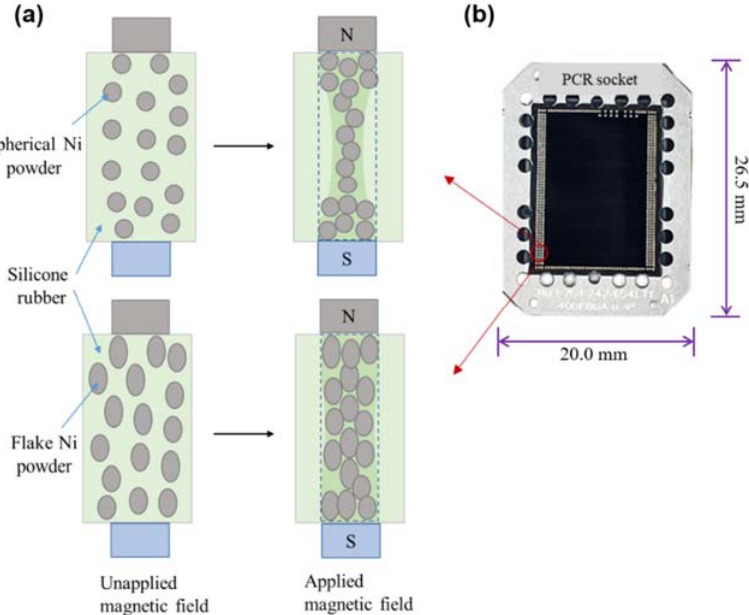
Figure 1. ( a ) Schematic diagram of the fabrication process of the pressure conductive silicone rubber socket device and ( b ) photograph of the prepared PCR socket